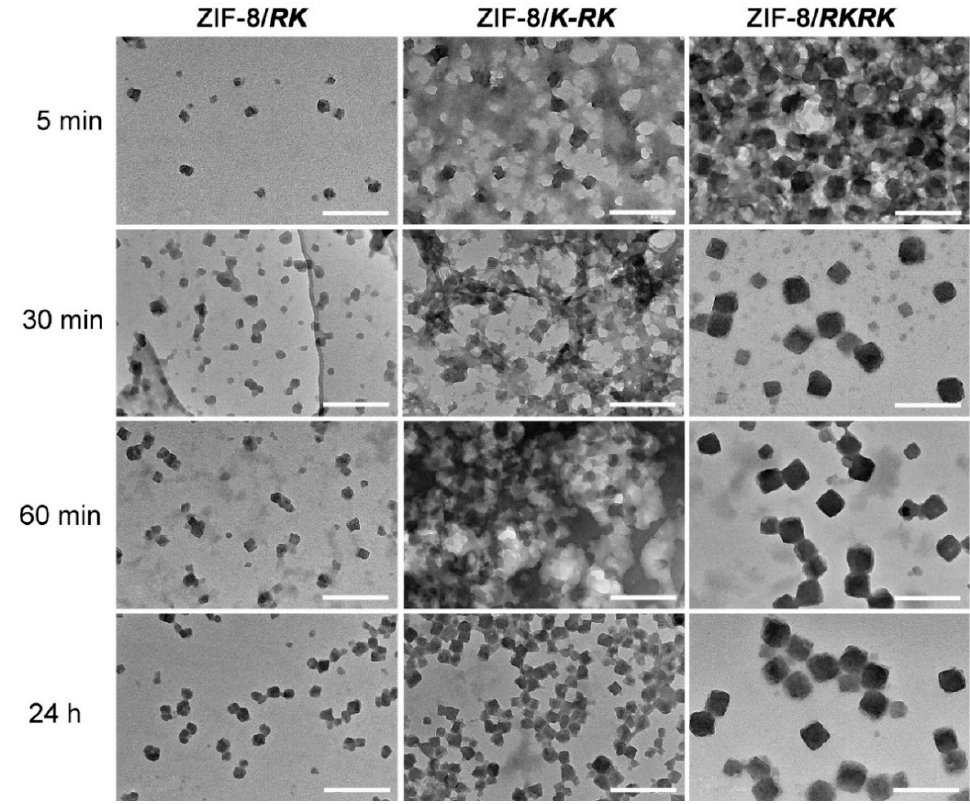
Figure 7. TEM characterization showing the morphology change of the ZIF-8 crystals prepared in the presence of each peptide at varied reaction times. Scale bar represents 200 nm for all images.